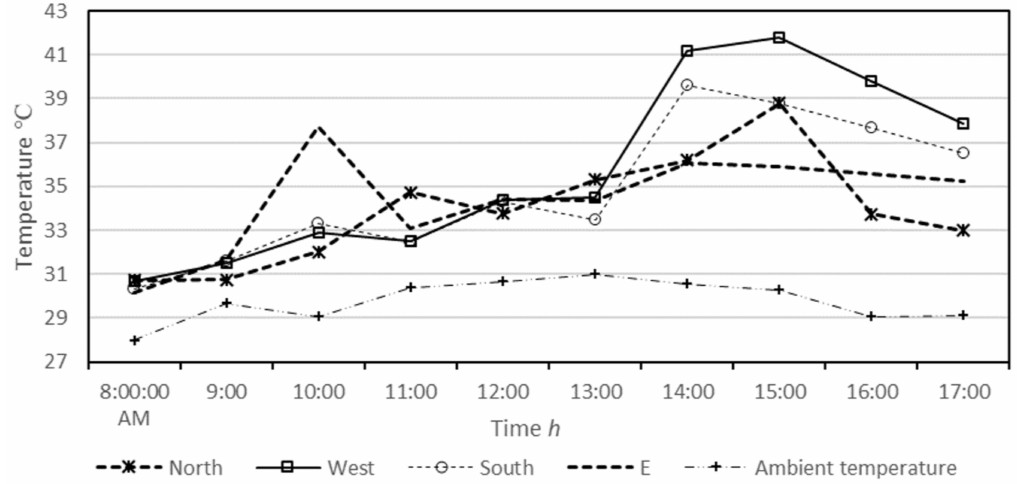
Figure10. Heatgainrisksonmicroclimatesaroundthebuildingwithtemperaturesreaching33 ◦ C–38 ◦ C in the morning on east and 35 ◦ C–42 ◦ C in the afternoon on